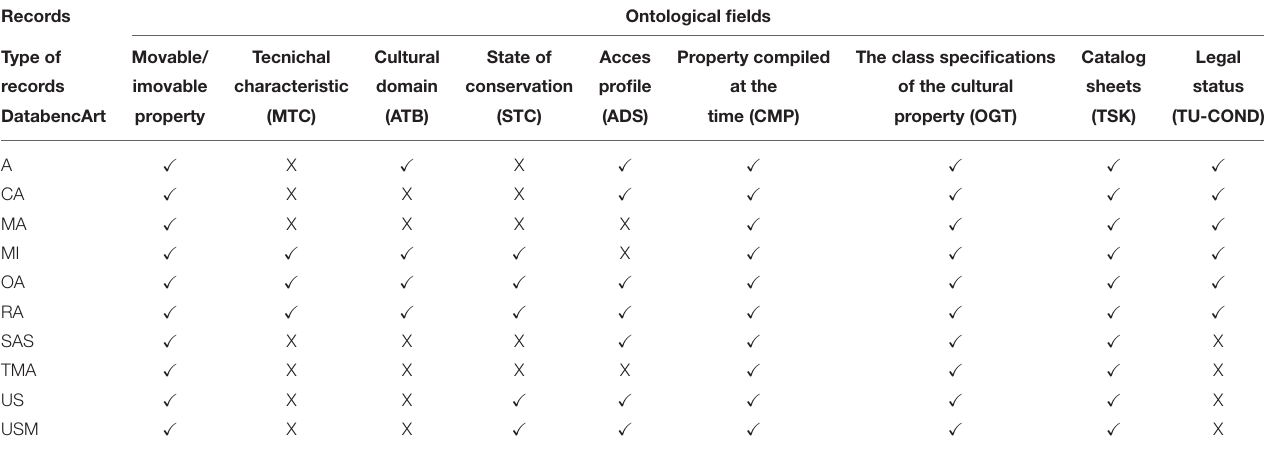
TABLE 1 | Correspondences between the modules of ArCo ontology and records of